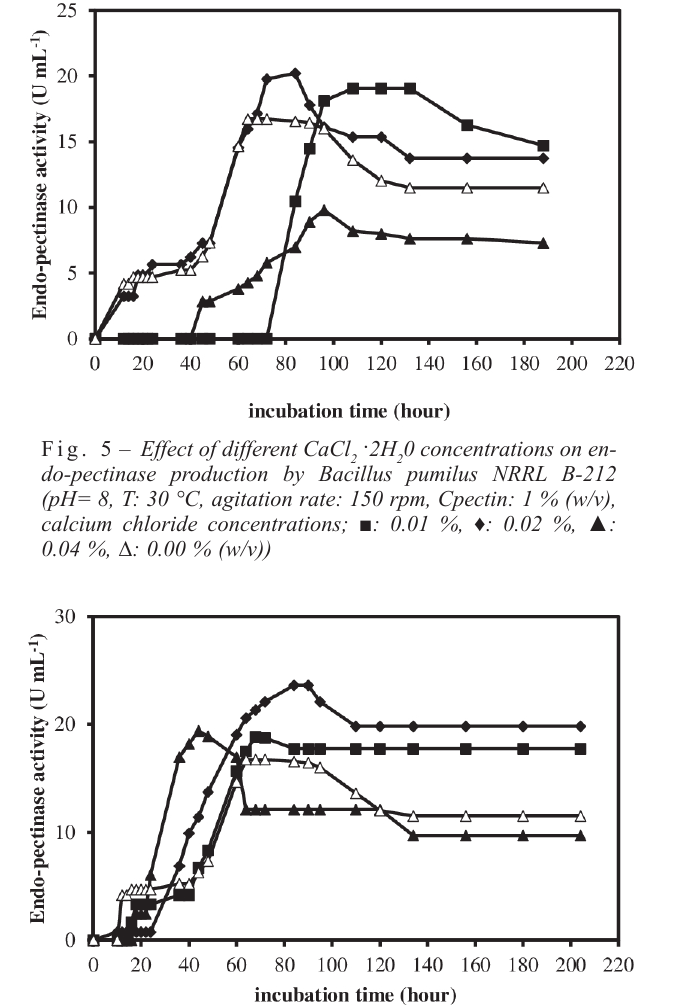
Fig. 6 – Effect of different NaCl concentrations on en- do-pectinase production by Bacillus pumilus NRRL B-212 (pH= 8, T: 30 °C, agitation rate: 150 rpm, Cpecin: 1 % (w/v), NaCl concentrations; ■: 0.01 %, ♦: 0.02 %, ▲ : 0.04 %, ∆ : 0.00 % (w/v))